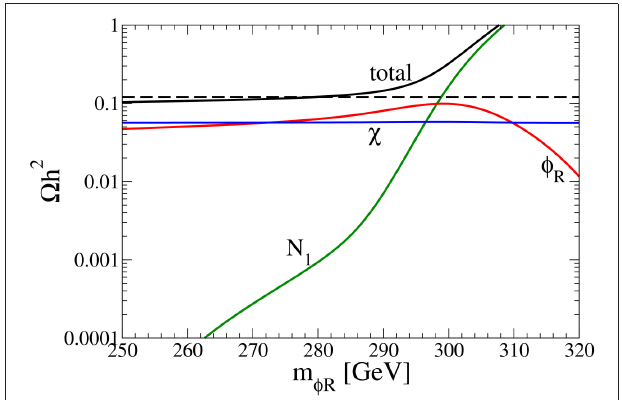
h 2 , and (cid:127) N h 2 and the total relic R 1 . The relevant masses and couplings R ∼